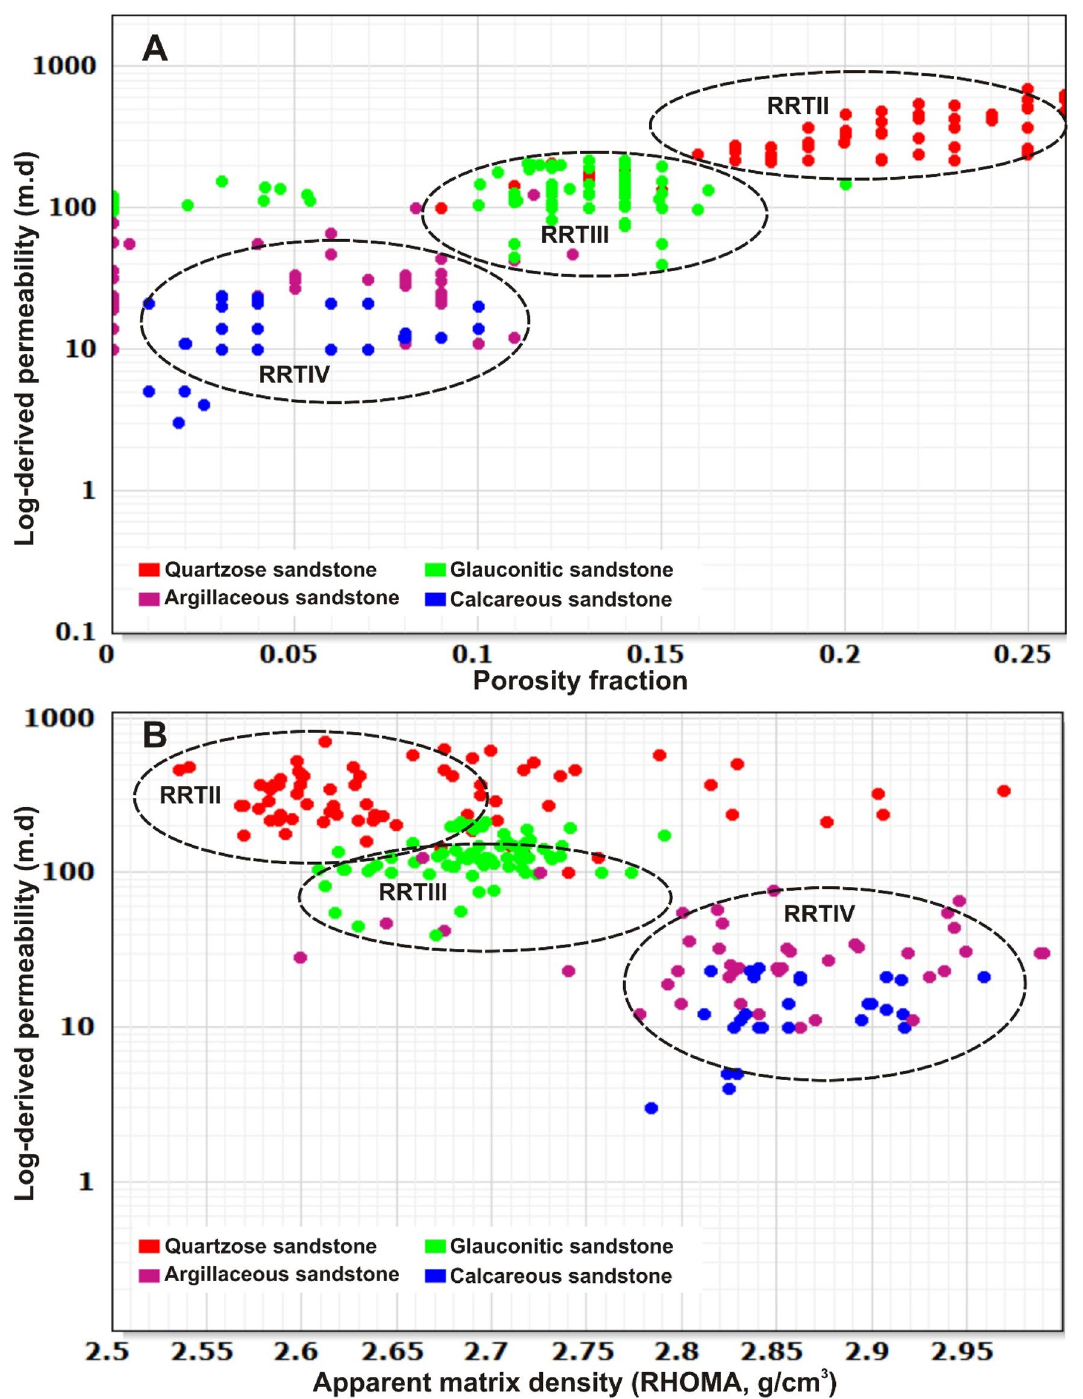
Fig. 14 Cross-plots of log-derived petrophysical parameters for the Abu Madi estuarine unit showing the absence of the best reservoir quality